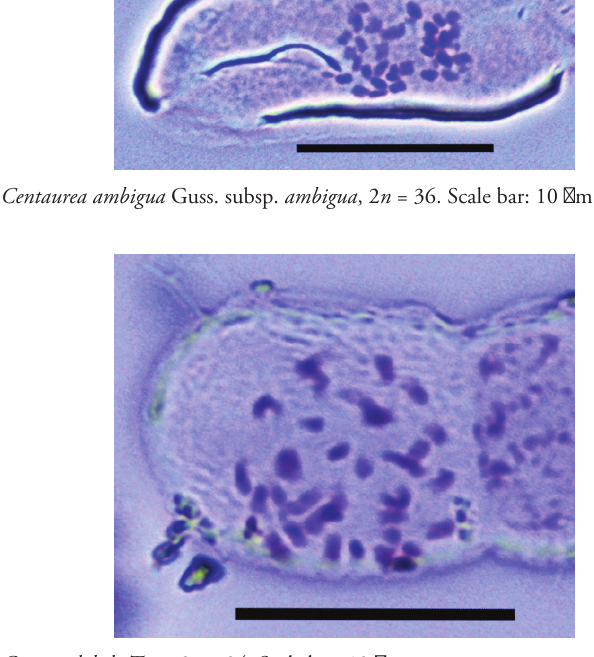
Figure 12. Cirsium lobelii Ten., 2 n = 34. Scale bar: 10